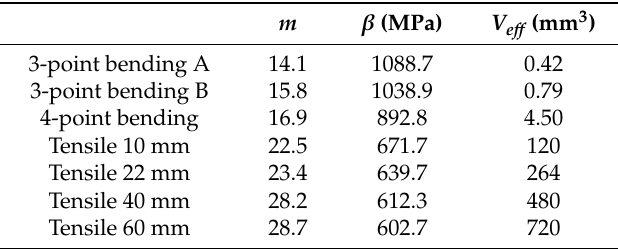
Table 3. Weibull parameter m , scale parameter β , and e ff ective volume V e ff corresponding to Figure